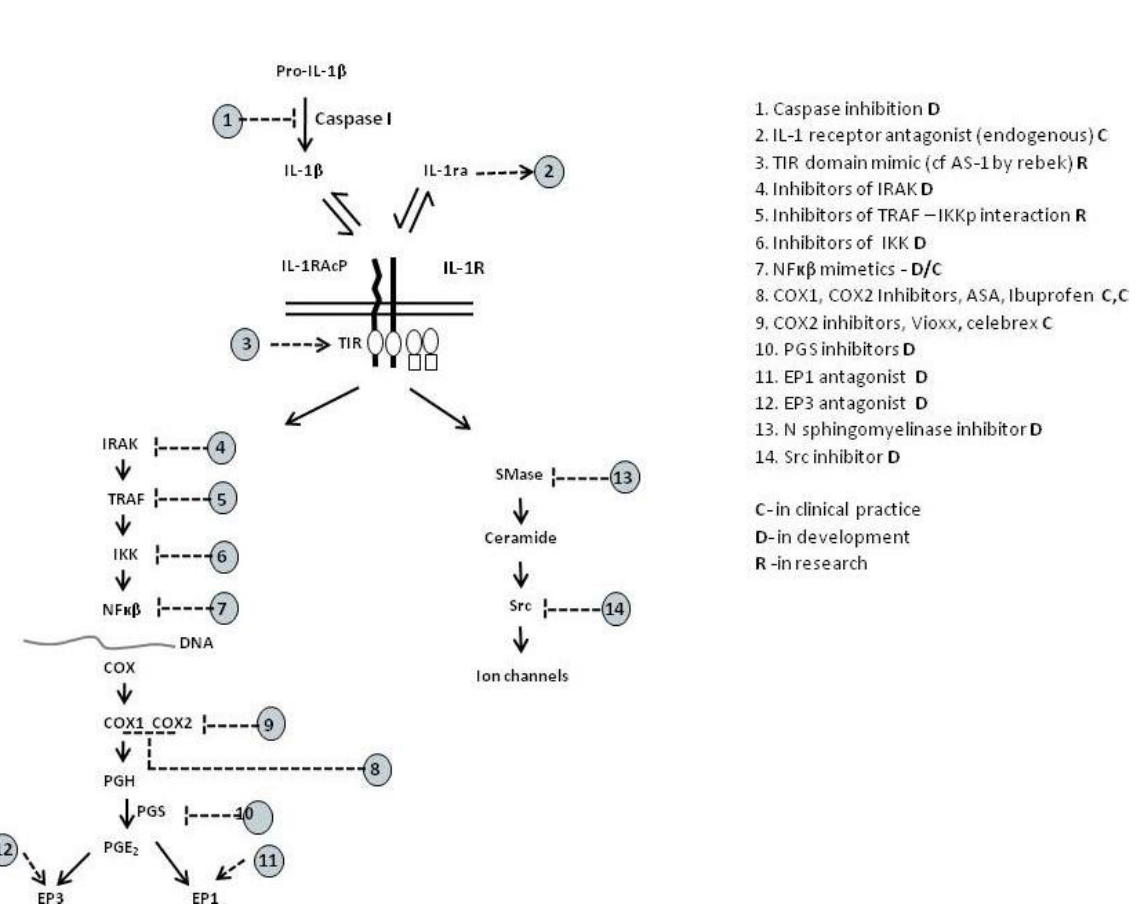
Toll signaling also includes multiple serine-threonine and tyrosine phosphorylations. Toll receptors, like IL-1R1, are phosphoproteins that are phosphorylated by Src-type soluble tyrosine kinases. Protein phosphatases are, of course, an integral part of the Toll signaling system, resetting the system to be able to respond